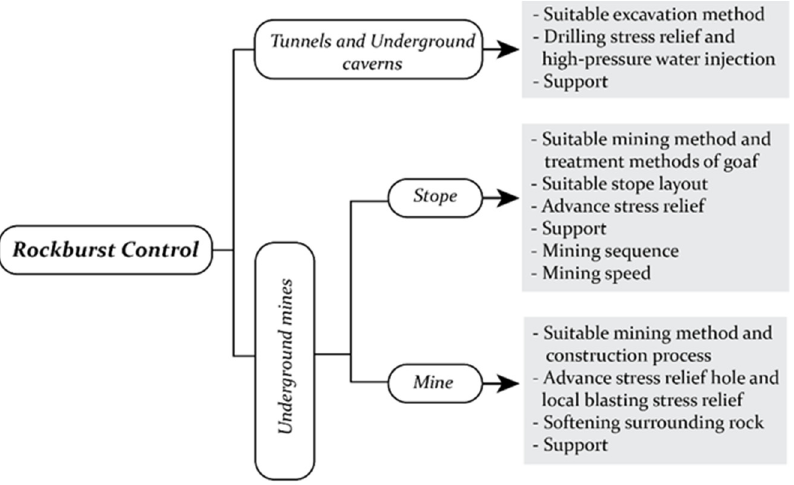
Figure 14. Control measures for rockbursts [11].